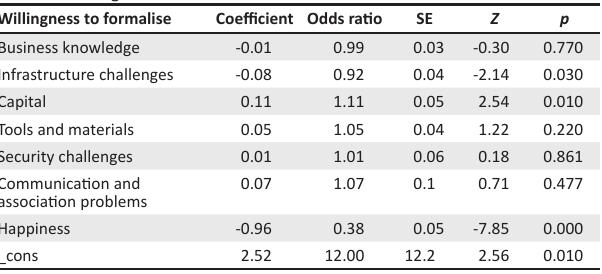
TABLE 5: Willingness to formalise. Willingness to formalise Coefficient Odds